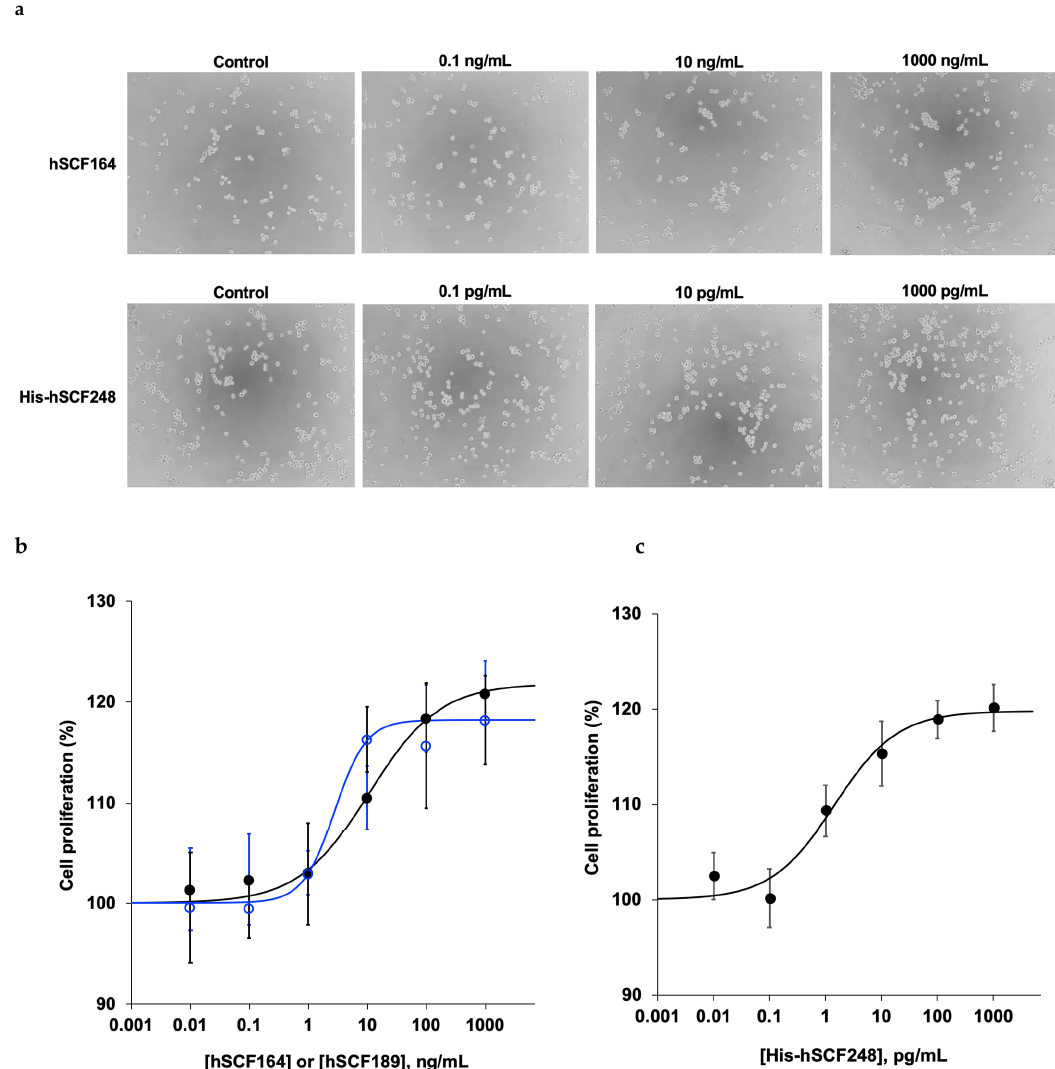
Figure 5. TF-1 cell proliferation assays of commercial hSCF164, and purified hSCF164 and His-hSCF248. ( a ) Microscope images of TF-1 cell growth that was promoted by treatment with purified hSCF164 and His-hSCF248 for 12 h. ( b ) Dose-dependent cell proliferation by hSCF164 (black closed circle) and commercial hSCF189 (blue open circle). ( c ) Dose-dependent cell proliferation by His-hSCF248.